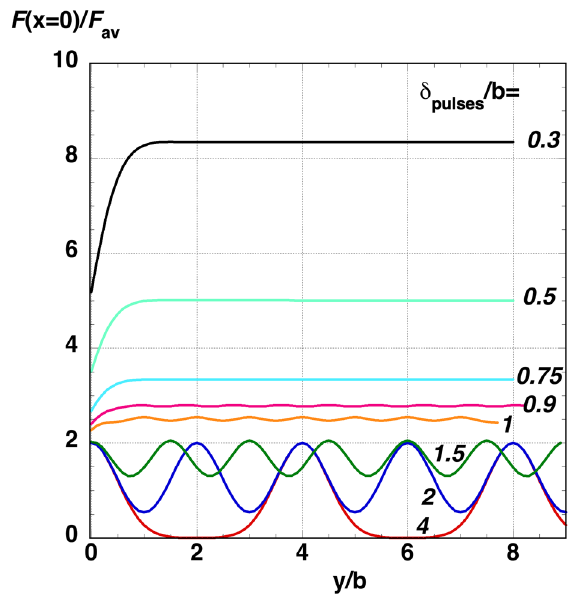
Figure 3. Normalized fluence distribution along a single scan line ( x = 0) when the laser beam scans in the y -direction.